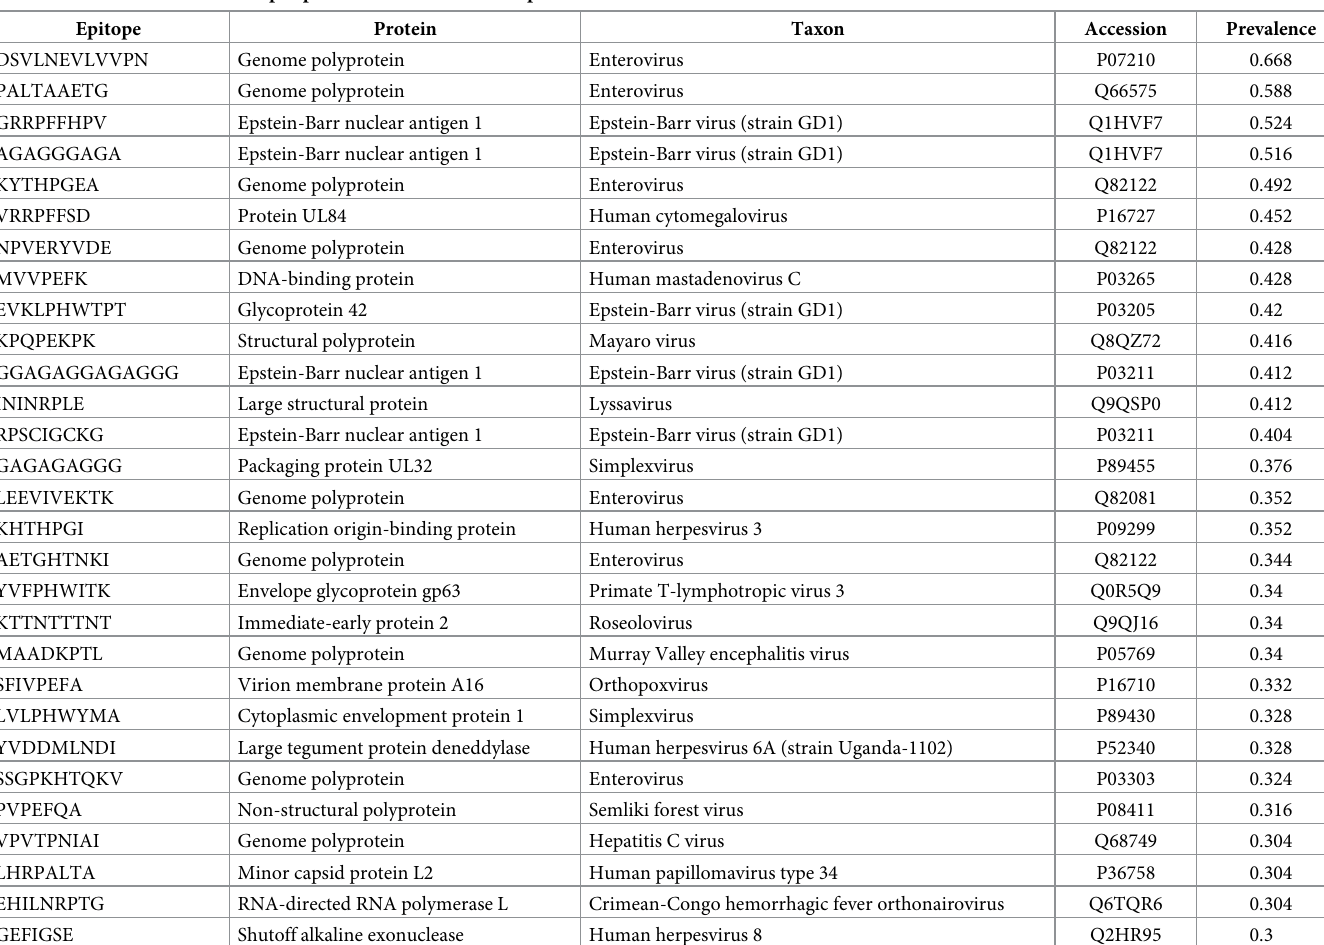
Table 1. A collection of 29 viral epitopes to which > 30% of 250 specimens